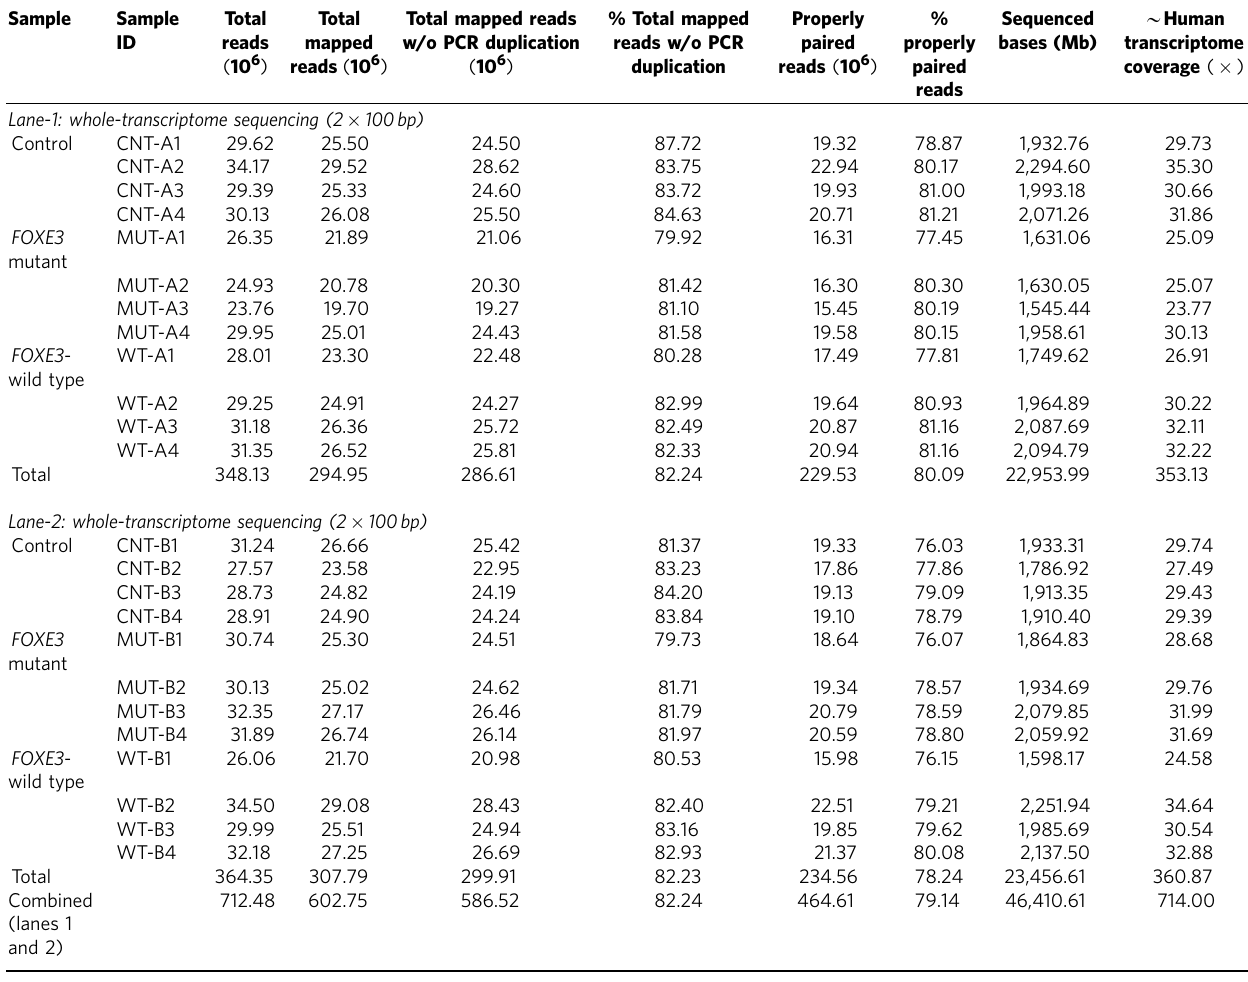
Table 1 | A summary of the transcriptome data of control, wild-type and truncated FOXE3-expressing cells. Sample